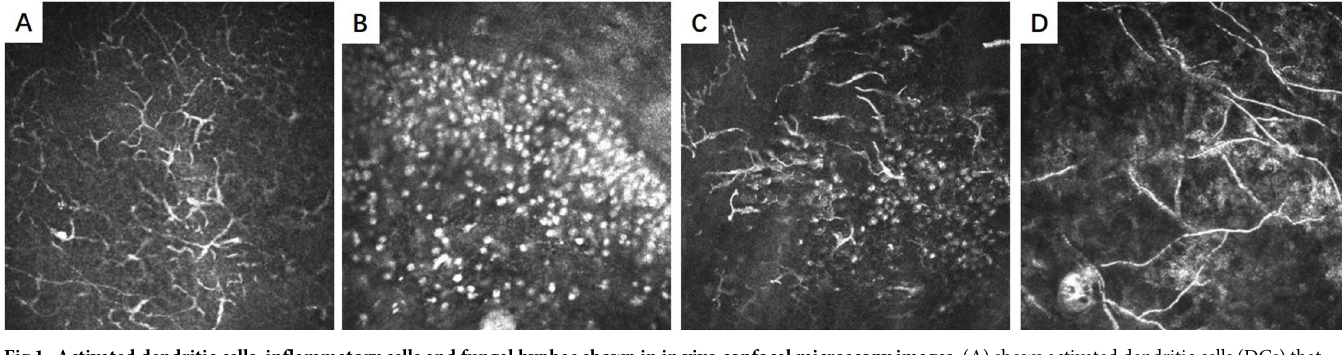
Fig 1. Activated dendritic cells, inflammatory cells and fungal hyphae shown in in vivo confocal microscopy images. (A) shows activated dendritic cells (DCs) that are characterized by hyperreflective branched structures, with long processes extending outwards in multiple directions from the cell body; (B) shows inflammatory cells that represent as small, round, bright hyperreflective cells; (C) shows the co-existence of activated DCs and inflammatory cells; (D) shows fungal hyphae that manifest as fine branched thread-like structures. https://doi.org/10.1371/journal.pone.0252653.g001 PLOS ONE | https://doi.org/10.1371/journal.pone.0252653 June 3,